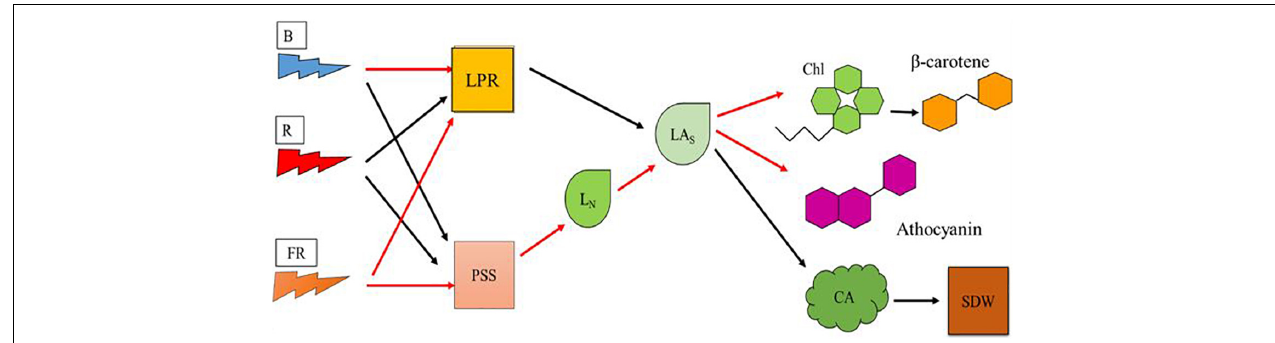
FIGURE 7 | A model showing the effects of blue, red, and far-red radiation on physiological responses at cellular and leaf scales that affect vegetative growth and pigment synthesis in romaine lettuce. Model parameters include blue light (B), red light (R), far-red light (FR), leaf photosynthesis rate (LPR), phytochrome photostationary state (PSS), average leaf number per plant (L N ), average area of individual leaf (LA s ), chlorophylls level (Chl), beta-carotene level ( β -carotene), anthocyanins level, canopy area (CA), and shoot dry weight (SDW). Black and red arrows indicate positive and negative relationships, respectively, between two